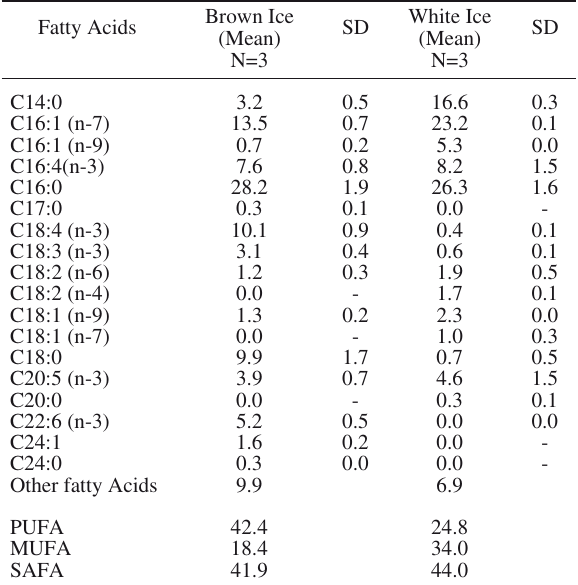
Fig . 4. – Total lipid and fatty acid concentrations (μg L –1 ) in ‘brown ice’ (first 3-5 cm of the ice layer in contact with the sea water) and ‘white ice’ (ice layer 15 cm from the surface in contact with the sea water) from the sample picked up on 15 Table 3. – Fatty acid composition (as a % of the total fatty acids) in the ice cores sampled on 15 December 2003 near the semi-perma- nent station of the Weddell Sea